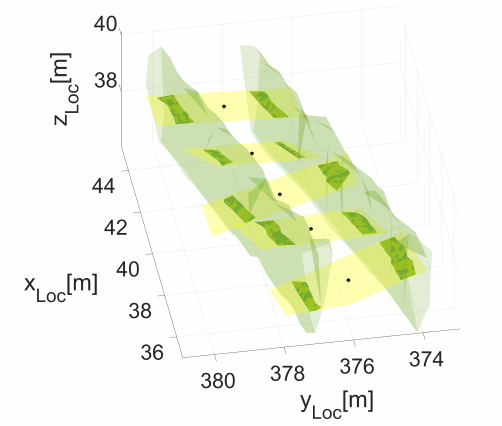
Figure 7. Evolution of the quadrotor center-of-mass position (black circles) within the LCG maps together with the approximating planes (yellow rectangles) and the generated 2D slices (dark green